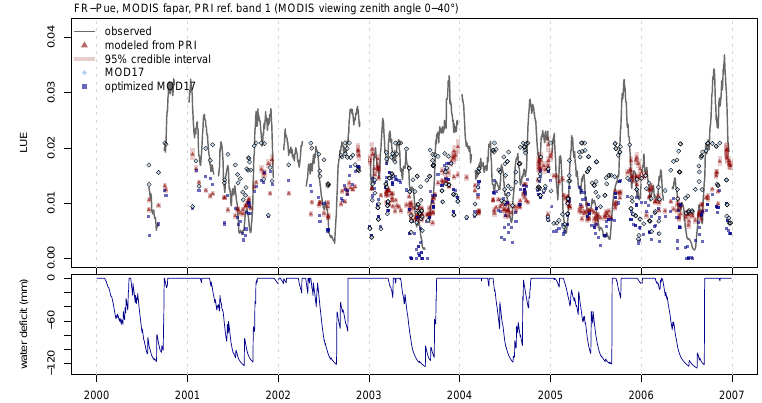
Fig. 6. Top: Time series of observed LUE as 14-day moving average (based on MODIS faPAR) and modelled LUEs (exponential model based on PRI with reference band 1, MOD17, and optimised MOD17) at the FR-Pue site. Bottom: Water deficit in mm (calculated from field capacity and in-situ soil water content measurements).